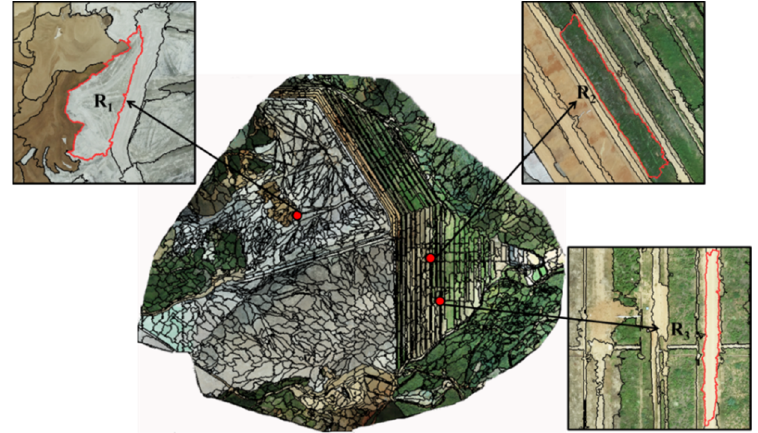
Figure 11. Segmentation results. R 1 is the tailing sand and a small part of bare soil mixed area. R 2 and R 3 were the mixed distribution areas of vegetation and bare soil.